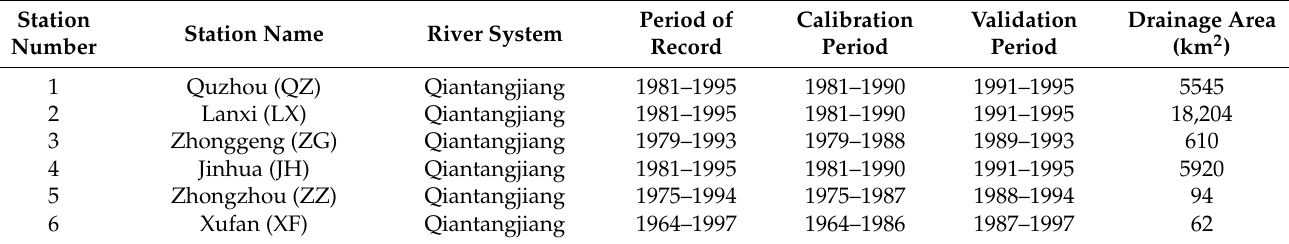
Table 1. Information on hydrological stations in the study